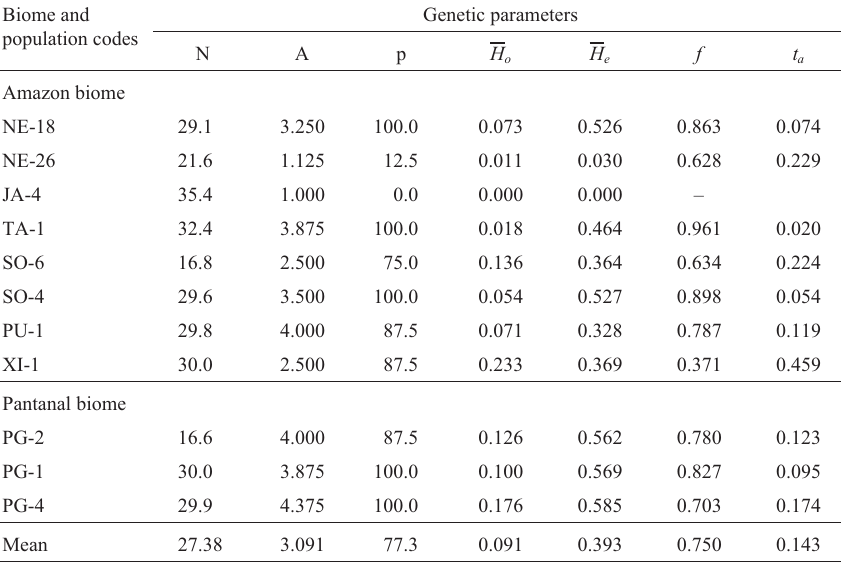
Table 4 - Average estimates of the genetic parameters based on eight microsatellite loci for eleven Brazilian Oryza glumaepatula populations: number of plants sampled per locus (N), average number of alleles per locus (A), percentage of polymorphic loci (p), observed heterozygosity across loci ( H o ), gene diversity ( H e ), fixation index ( f ) and apparent crossing rate ( t a